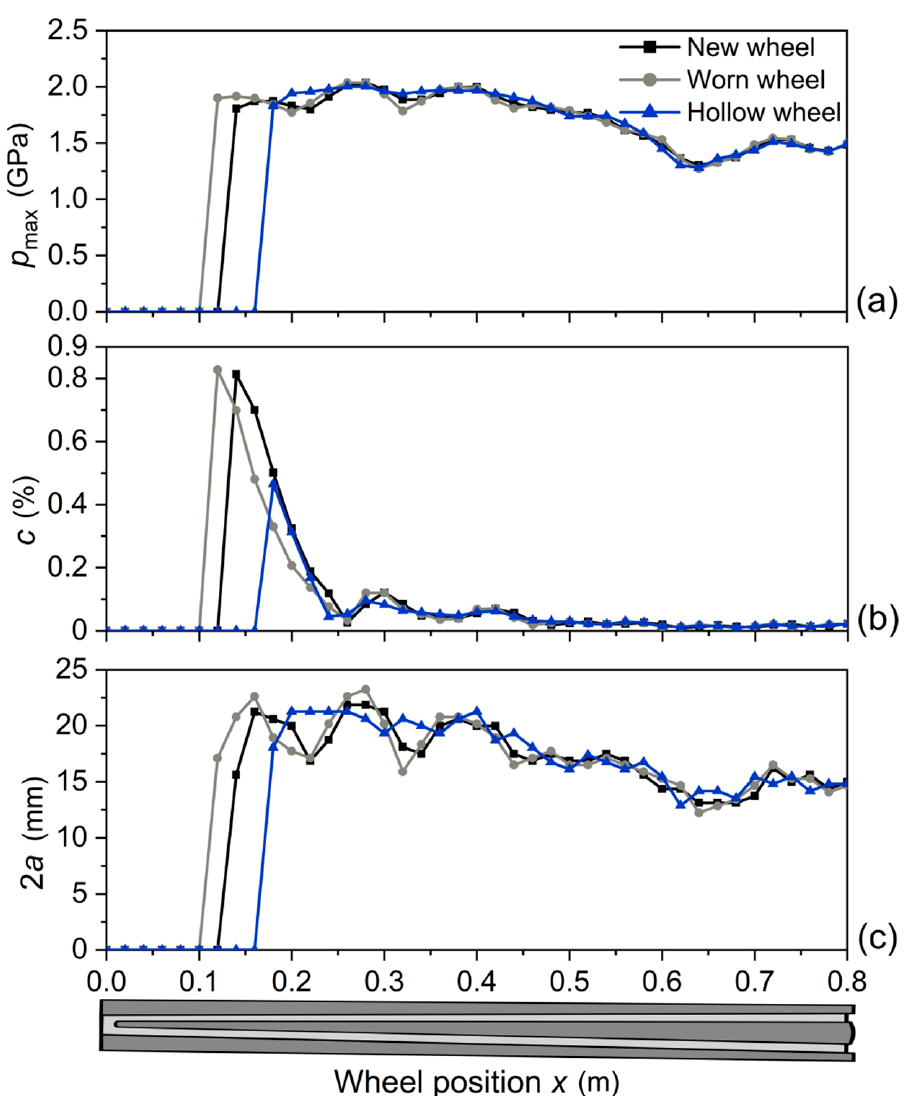
Figure 13. Loads at the local contact-patch level computed from the FEA for the impact of differently worn wheel profiles on the run-in crossing nose (11.9 MGT): ( a ) maximum contact pressure ( p max ), ( b ) creepage ( c ) and ( c ) contact length (2 a ).